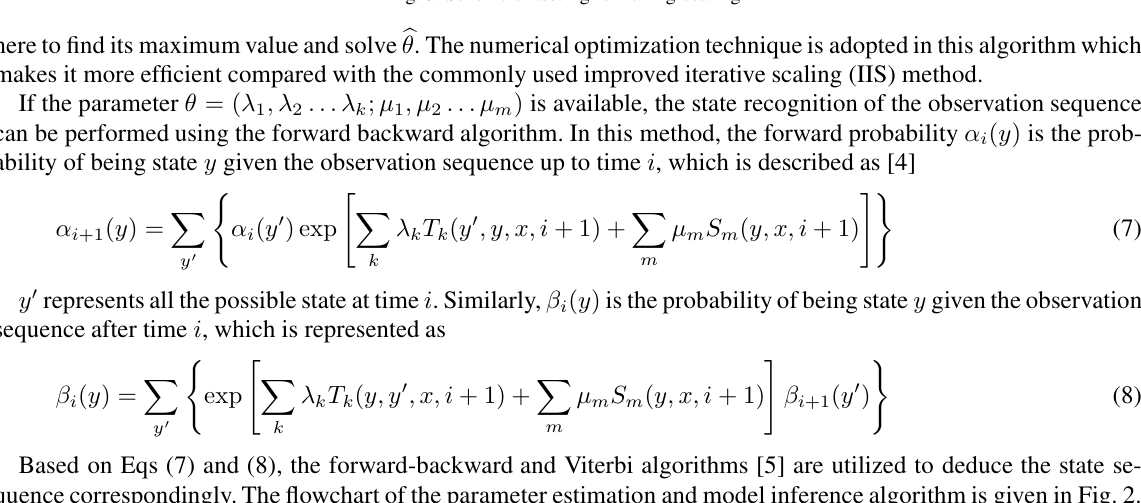
Fig. 3. Scheme of test rig for rolling